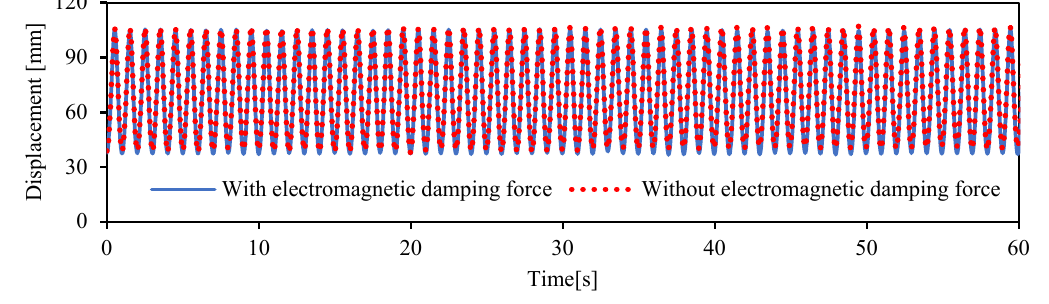
Figure 26. Effect of electromagnetic damping on vibration displacement.